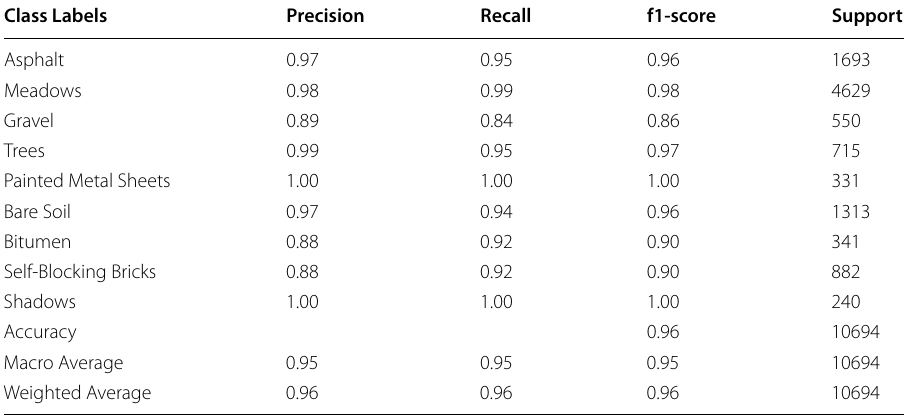
Table 14 Detailed classification test results for the Pavia University Dataset in terms of Precision, Recall, and F1-Score. Testing was done with PCA 30 CEU-Net no-patching with a 75%/25%